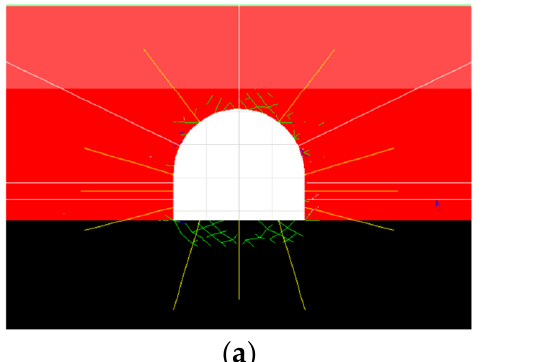
Figure 16. Crack distribution of the improved support. ( a ) 5th d; ( b ) 300th d. As can be observed form Figure 17, on the 300th day, the total number of cracks in the surrounding rock was 1073, including 976 shear cracks (accounting for 91%) and 97 tensile cracks (accounting for 9%). Compared with those in the original support method, the total number of cracks decreased by 46.4%; the number of shear cracks fell by 44.7%; and the number of tensile cracks declined by 37%. In the primary deformation stage, the cumulative number of shear cracks was 950, accounting for 97% of the total number of shear cracks. In the secondary deformation stage, 26 new shear cracks appeared, accounting for 3%